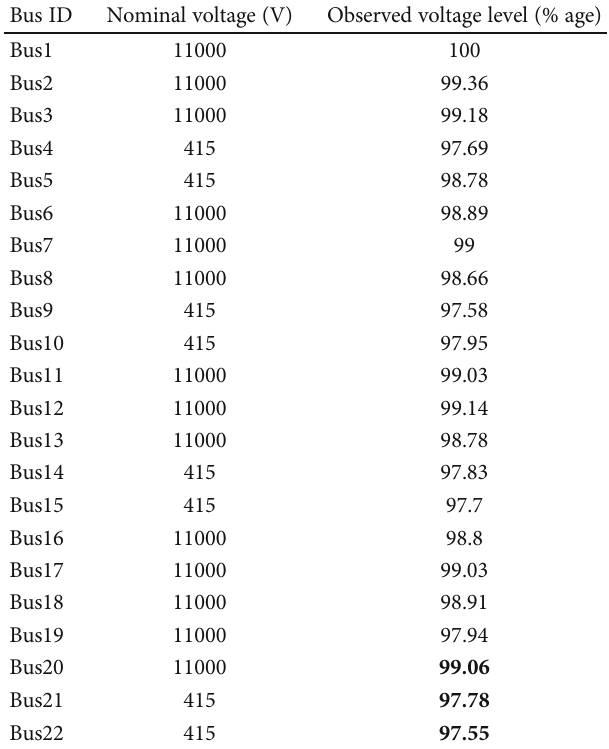
Table 4: Voltage pro fi le in Case 1.